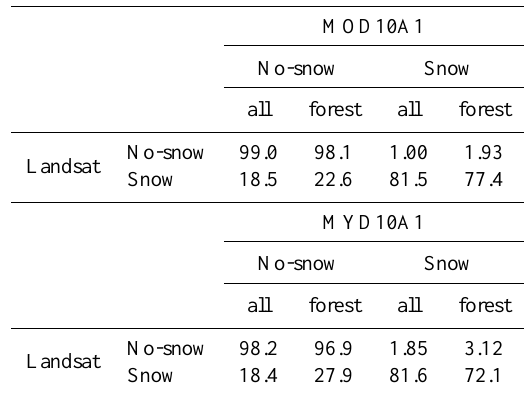
Table 4. Confusion matrix obtained from the comparison of Land- sat snow maps with Aqua/Terra MODIS snow maps. The numbers correspond to percentage with respect to Landsat data. The results are given for all the study area (all), and the area covered by forests only (forest).